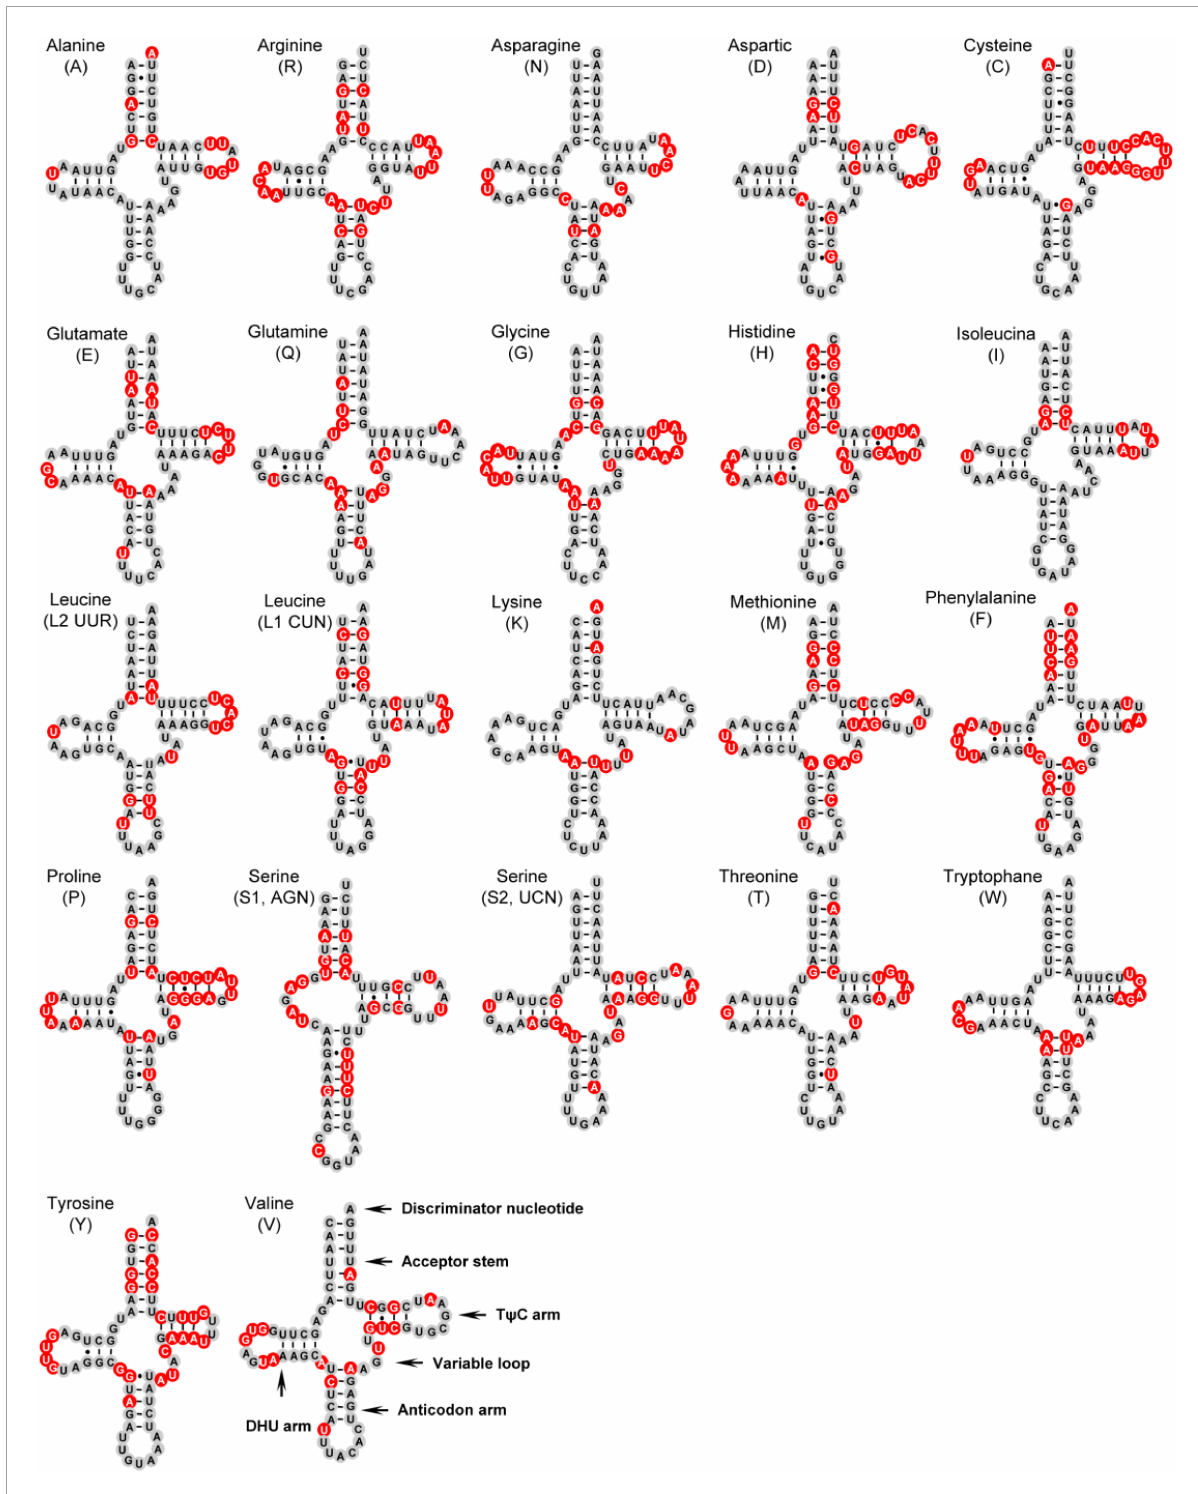
FIGURE5 Putative secondary structures of tRNAs found in the Cryptoperla kawasawai mitogenome. Completely conserved sites within the six peltoperlid species were marked by black nucleotides within gray spheres. Inferred Watson–Crick bonds are illustrated by lines, whereas guanine–uracil (GU) bonds are illustrated by